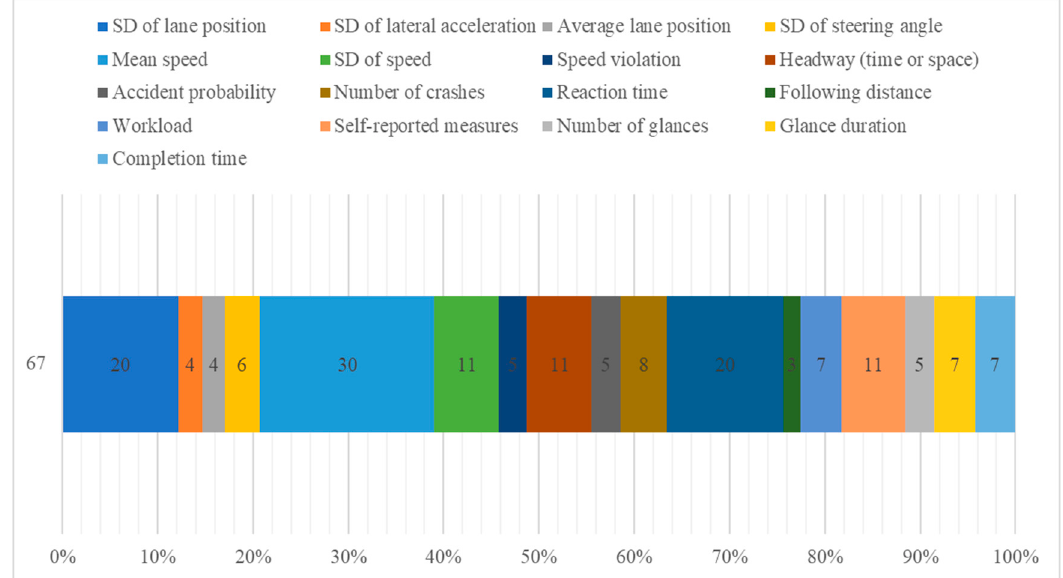
Figure 8. Main measures used in the experiments of the examined studies (SD—standard devia-